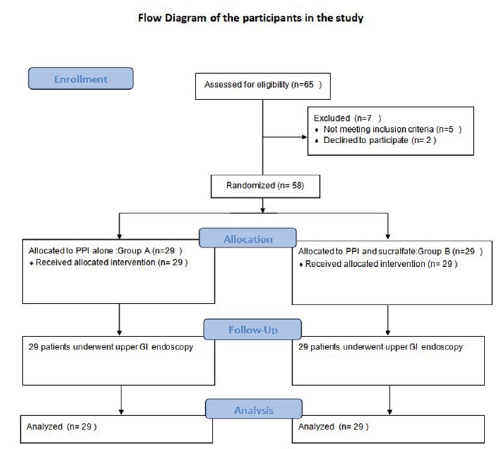
Figure 1: Participant flow chart as per CONSORT